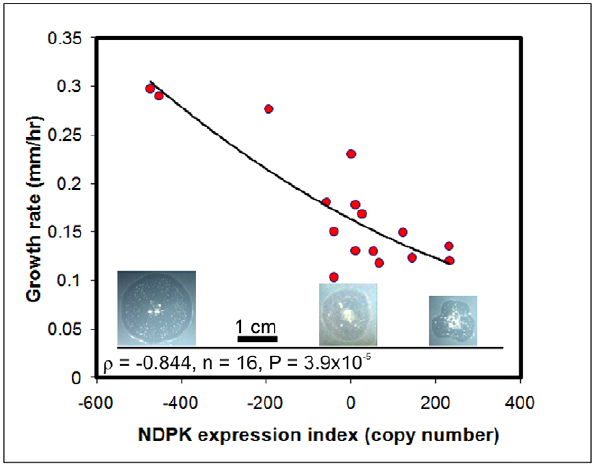
Figure 5. NDPK inhibits growth on bacterial lawns. The rate of expansion of wild type (0 copies – cells contain neither the antisense nor the overexpression construct) and NDPK transformant colonies (plaques) was measured in three independent experiments. The number of copies of the antisense (negative numbers) and overex- pression (positive numbers) constructs within the genome were used as an NDPK expression index. Each point represents the mean of data obtained for a single transformant. Plaque expansion rates were negatively correlated with the NDPK expression index (copy number). The correlation was significant at P , 0.01 (Pearson product-moment correlation coefficient r ). Representative plaques (with scale bar) after 3 days incubation are shown for an antisense inhibition strain (left side - 473 copies), the wild type strain (middle - AX2) and an overexpression strain (right side - 232 copies).